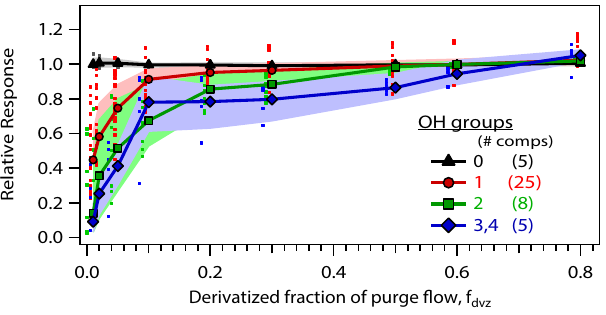
Figure 2. Response of 43 oxygenated compounds dependent on quantity of MSTFA introduced, normalized to the average response of each compound at f dvz > 0.5. Solid lines and symbols are the median relative response of all injections at each derivatization level, with the interquartile range shown as the shaded area. Com- pounds used are listed in the Supplement. Average response of each compound at each derivatization level is shown as a small dot of the appropriate color (slightly offset to the left) to show spread of the